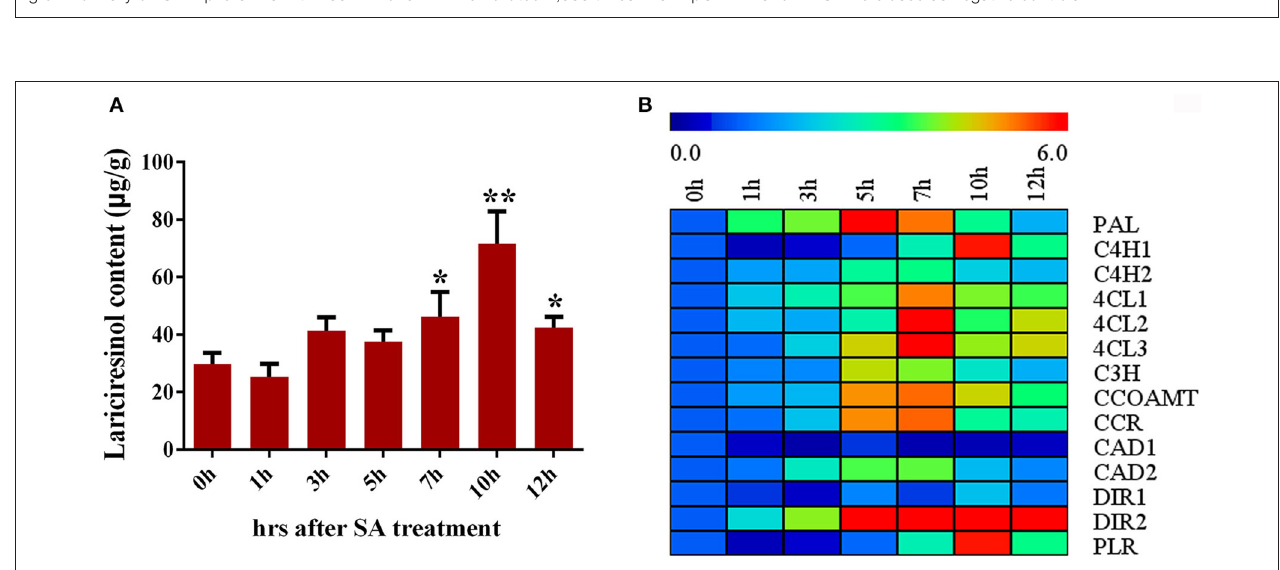
FIGURE 7 | Regulation of SA on lignan biosynthesis in I. indigotica . (A) Lariciresinol contents under SA treatment (asterisks indicate values that are significantly different) * P < 0.05, ** P < 0.01, from 0 h (Student t -test). Error bars indicate SD of three biological replicates. (B) Relative expression level of lignan biosynthetic genes under SA